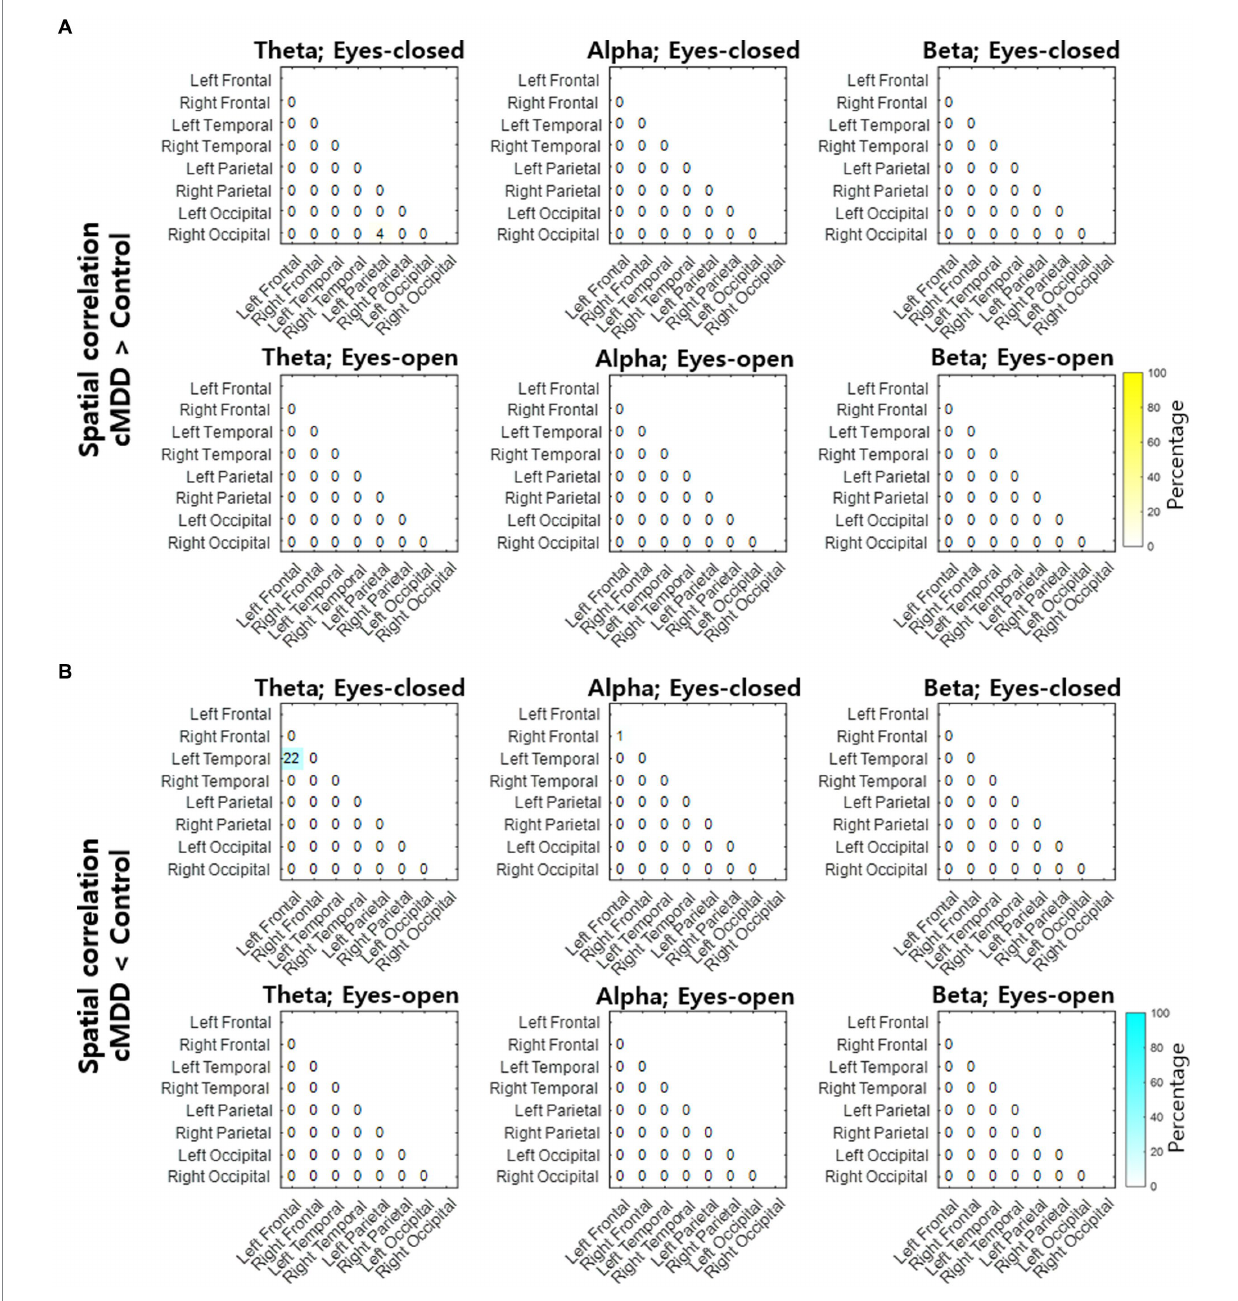
FIGURE 5 Differences of spatial correlation of infraslow amplitude fluctuations between current major depressive disorder and control groups. (A) The ratio (percentage) of channel pairs that the spatial correlation was significantly higher in cMDD than in control group (rank-sum test, FDR-corrected p < 0.05). (B) The ratio (percentage) of channel pairs that the spatial correlation was significantly lower in cMDD than in control group (rank-sum test, FDR- corrected p <